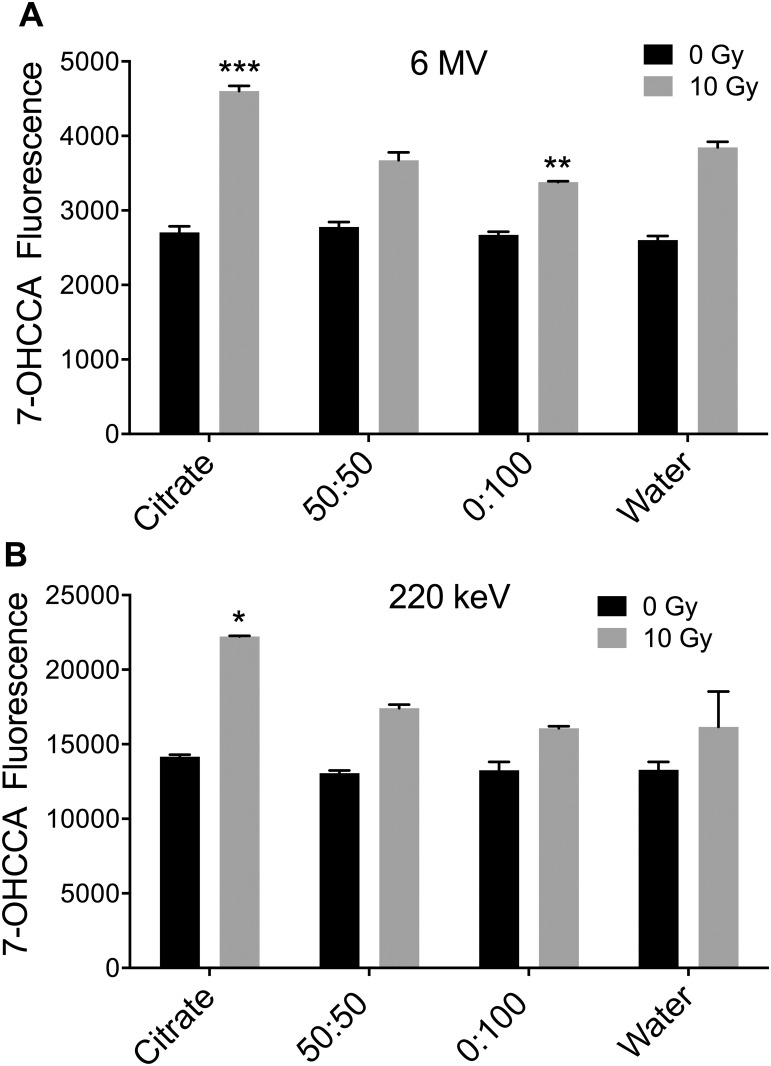
Hydroxyl radical formation assay of three different 6 μg/ml AuNP preparations in water with or without exposure to 10 Gy of A) 6 MV X-rays or B) 220 keV X-rays.Significant differences in fluorescence of 7-OHCCA probe following irradiation, compared to irradiated water only are indicated as P<0.05 *, P<0.01 **, P<0.001 *** (ANOVA with Dunnett’s multiple comparisons post test).